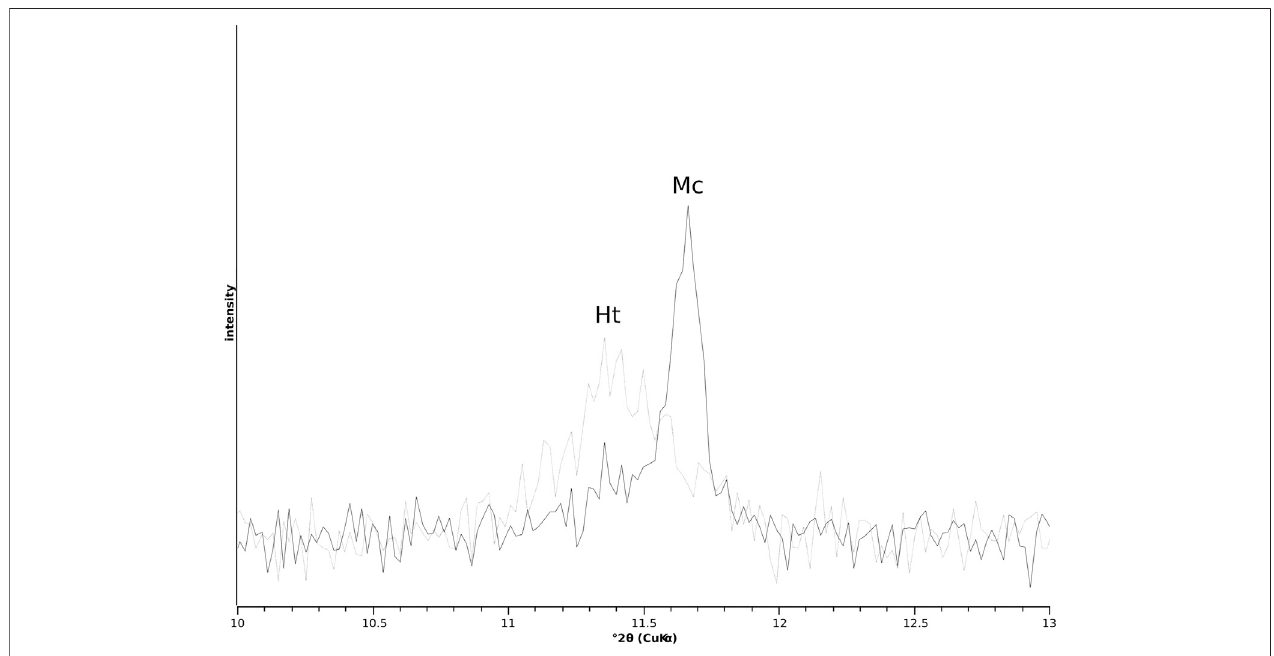
FIGURE 3 | Detail of the X-ray diffractograms of the powdered surface layers of the hardened cement paste fl at prisms 65_SO (dashed line, storage in sodium sulfate solution (30 gl − 1 SO 2 − 4 ) and 65_OH (solid line, storage in saturated calcium hydroxide solution). Ht: hydrotalcite; Mc: